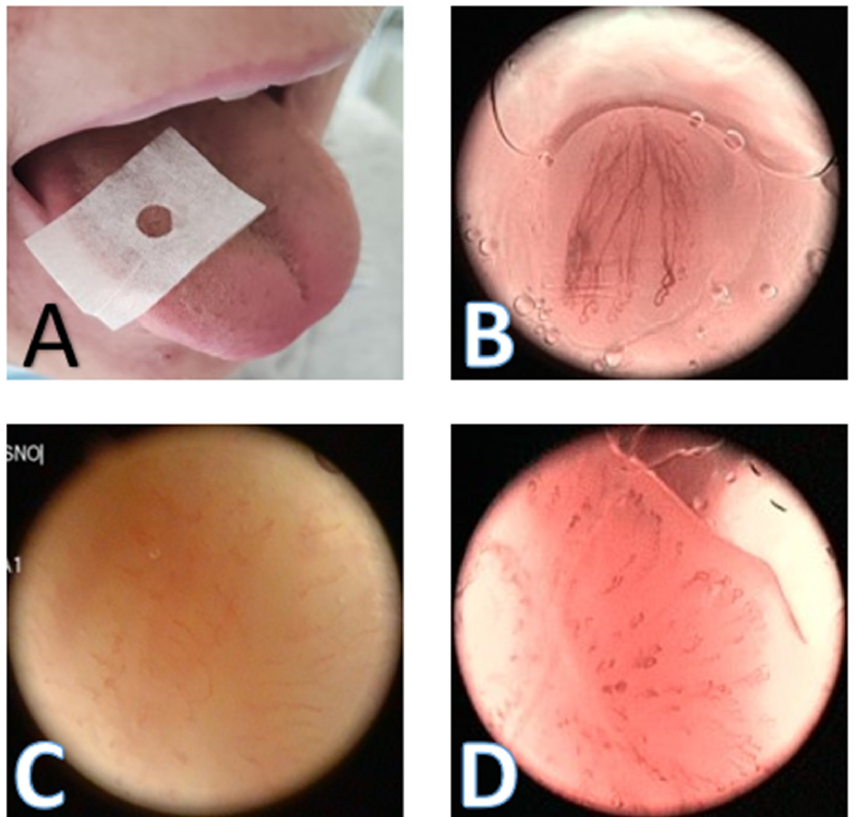
Figure 1. NBI contact endoscopy. ( A ) The tongue with the special plasticized paper with the 20 mm² holes positioned in the anterior 2/3 of the lateral tongue; ( B ) the NBI contact endoscopy picture of FP type A; ( C ) the contact endoscopy picture of FP type D without the use of the NBI; and ( D ) the contact endoscopy picture of FP type D with the use of the NBI; NBI—Narrow band imaging; FP—Fungiform papillae.